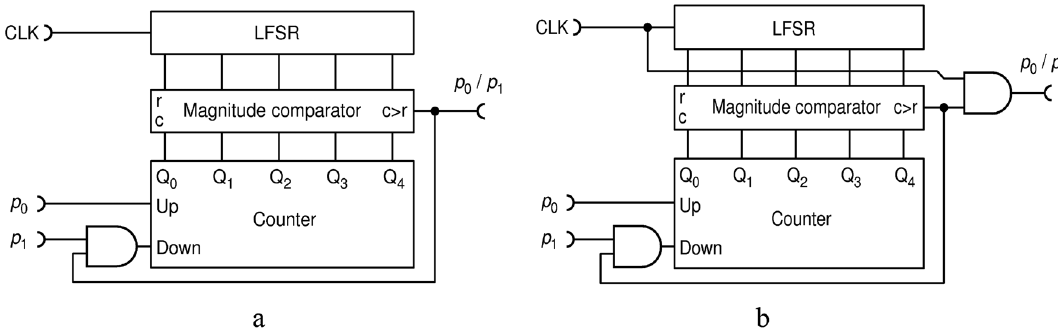
Figure 8. Feedback based division circuit: full-width-pulse version (a) ; half-width-pulse version (DIV1) (b)